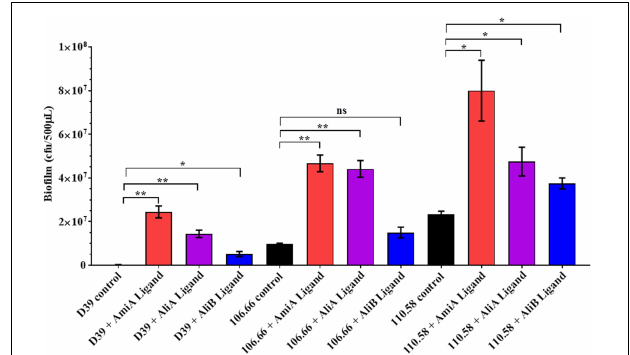
FIGURE 5 | Effect of peptides on biofilm formation. Quantitative analysis of in vitro biofilm formation of strains D39, 106.66, and 110.58 on Detroit 562 nasopharyngeal epithelial cells in the absence and presence of peptide ligands (0.5 mg/mL) in CDM after 16 h of static incubation. Results are